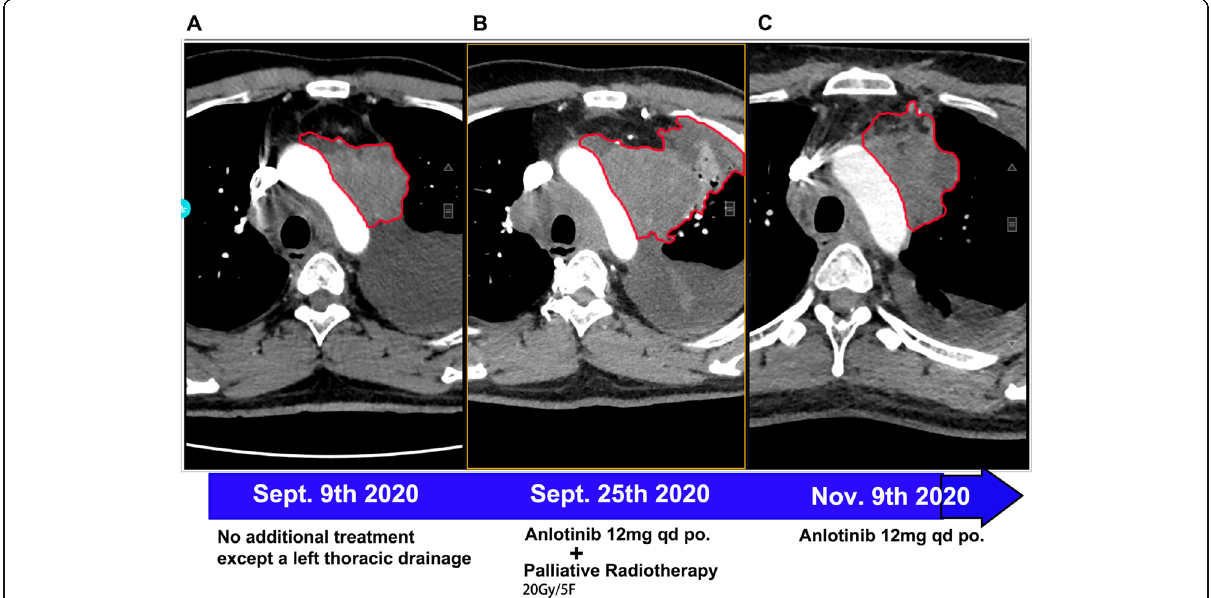
Fig. 4 The biopsy tissue from left supraclavicular lymph node showed that the possible metastases from pulmonary NMC. A : Hematoxylin-eosin (HE) staining demonstrated a NUT midline carcinoma with aberrant squamous differentiation. B : IHC staining with p63 protein showed obviously positive. Scale bar = 50 μ m